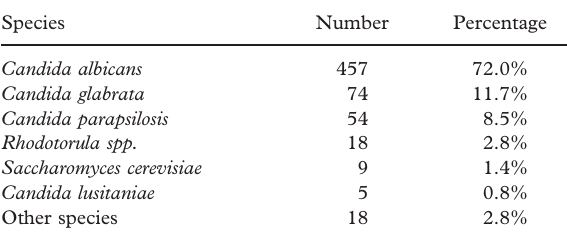
Table I. Distribution of yeast